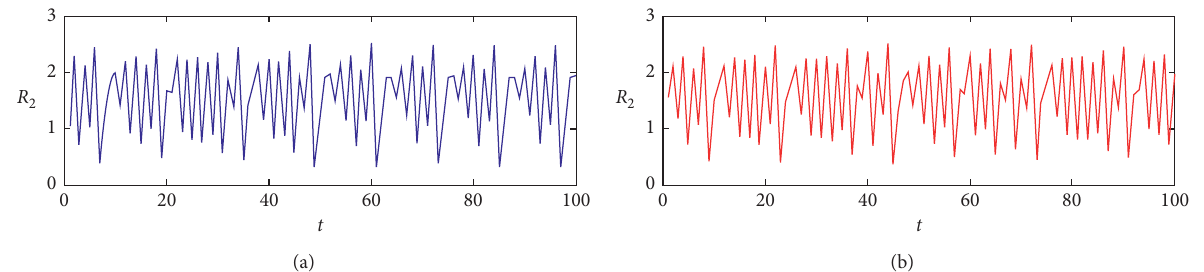
Figure 13: Orbits of R